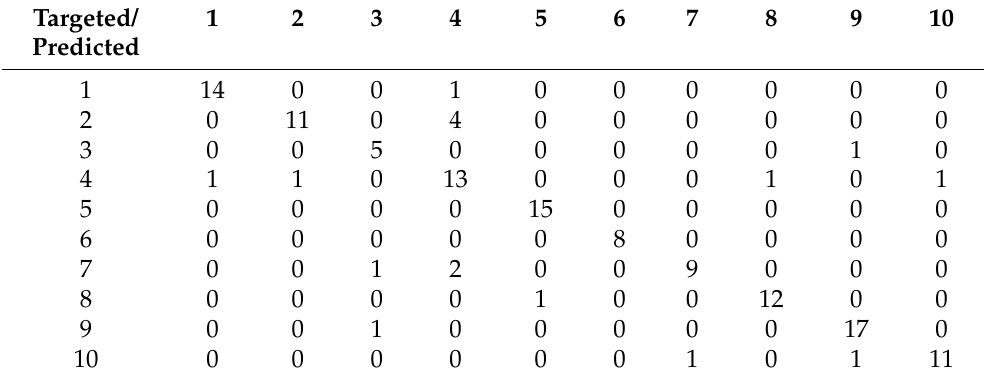
Table 4. The example of the confusion matrix for UCF50mini.